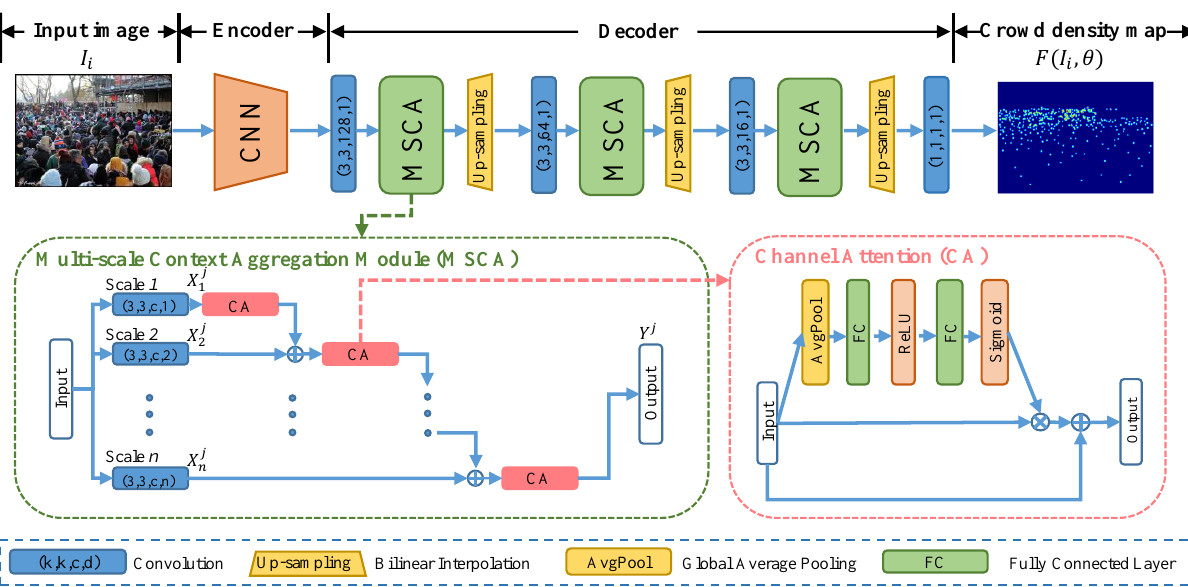
Figure 2. Detailedillustration of our Adaptive Multi-scale Context Aggregation Network for crowd counting.